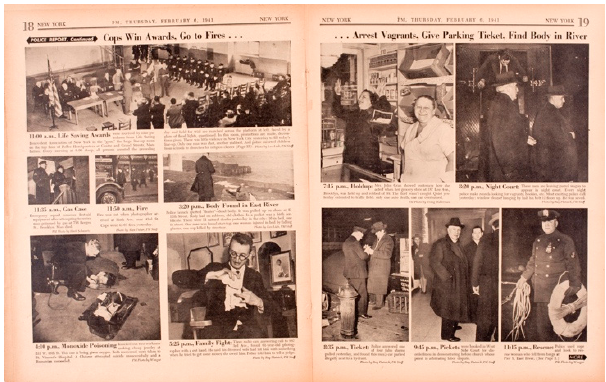
Figure 11. “Police Report”, PM , 6 February 1941. Image courtesy of the International Center of Photography.